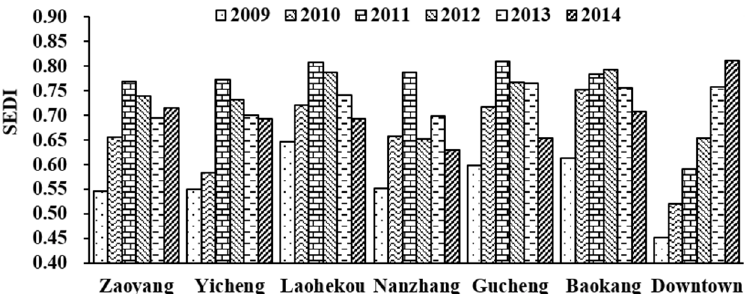
Figure 7. Temporal variation process of SEDI in Xiangyang City.